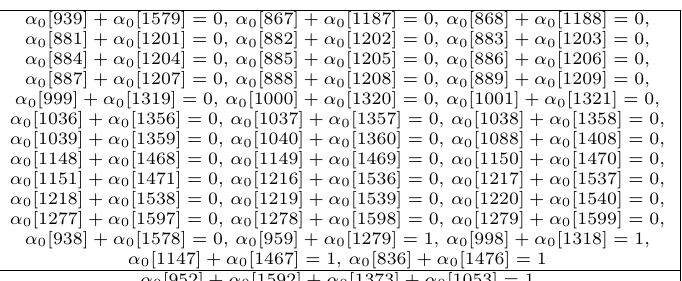
Table 9: Conditions on chain values.